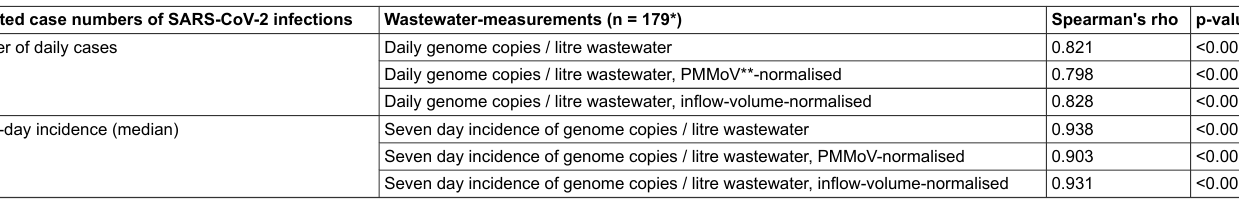
Table 1: Correlations between different wastewater measures of SARS-CoV-2 viral loads and reported case numbers of SARS-CoV-2 infections (n = 179) Reported case numbers of SARS-CoV-2